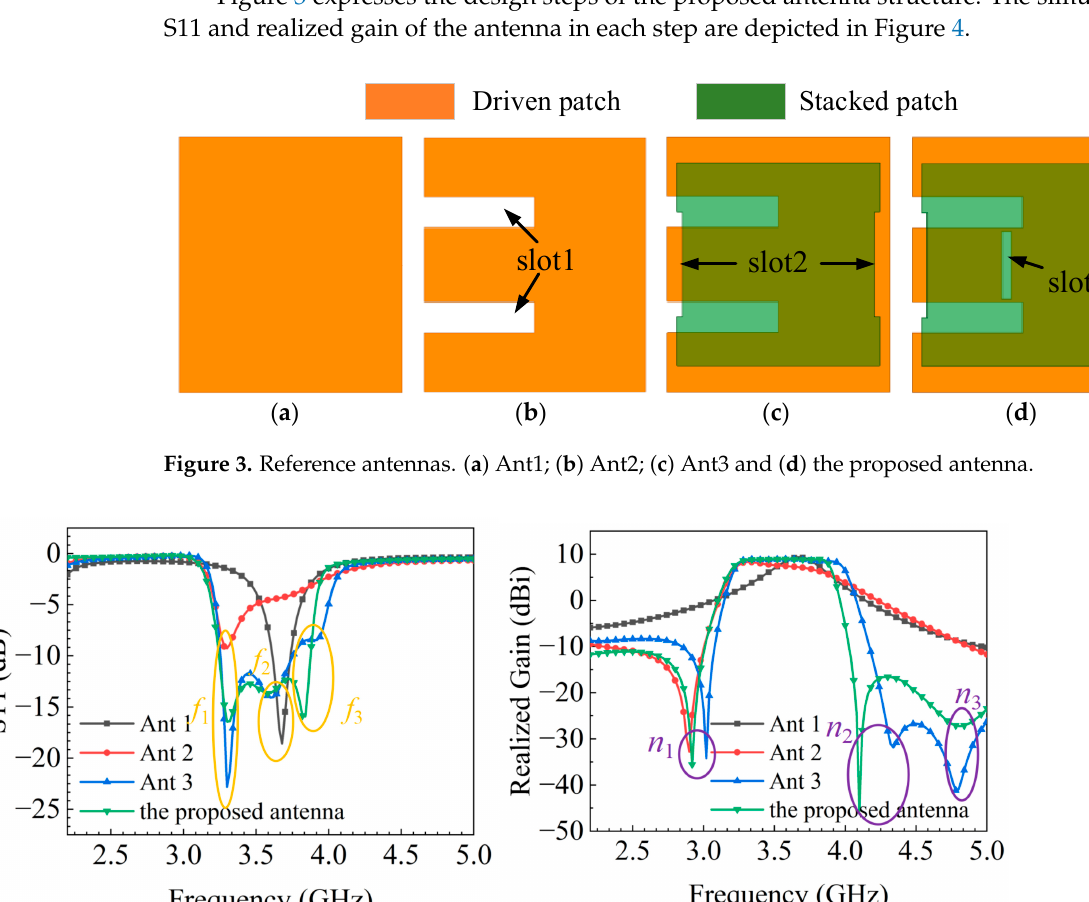
Figure 2. Configurations at each layer. ( a ) G5 layer; ( b ) G2 layer; ( c ) G6 layer.